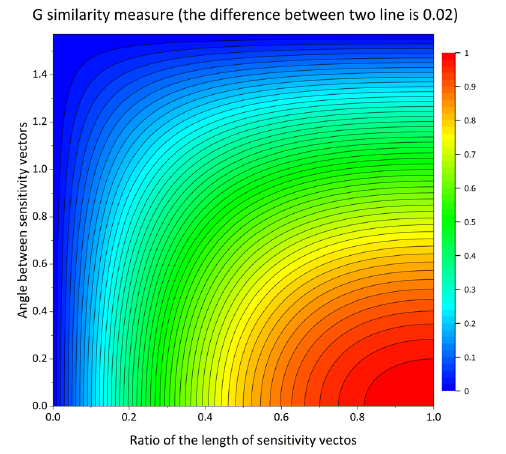
Figure 1. G similarity